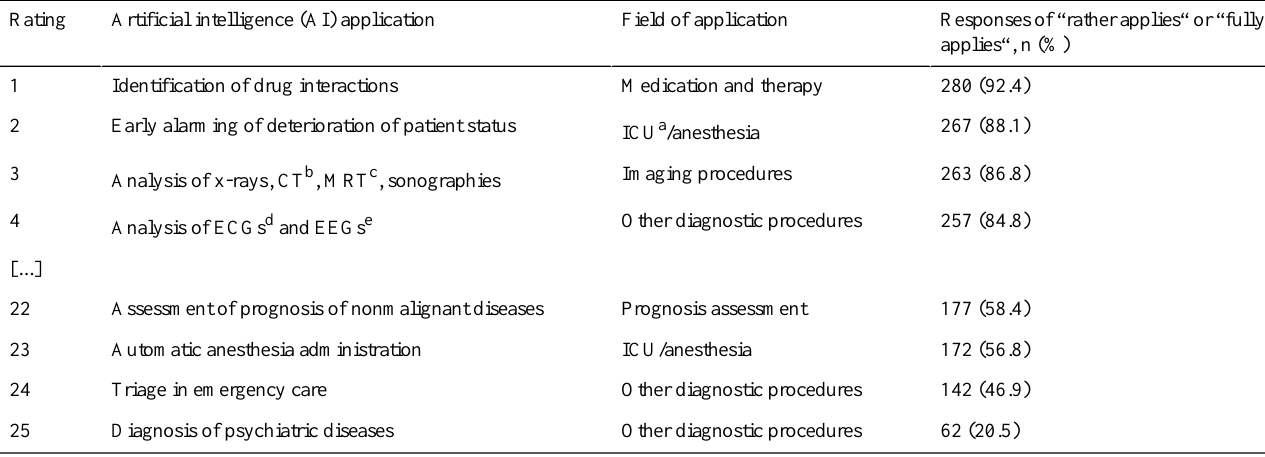
Table 2. Applications with the highest-rated and lowest-rated potential to improve patient care in the